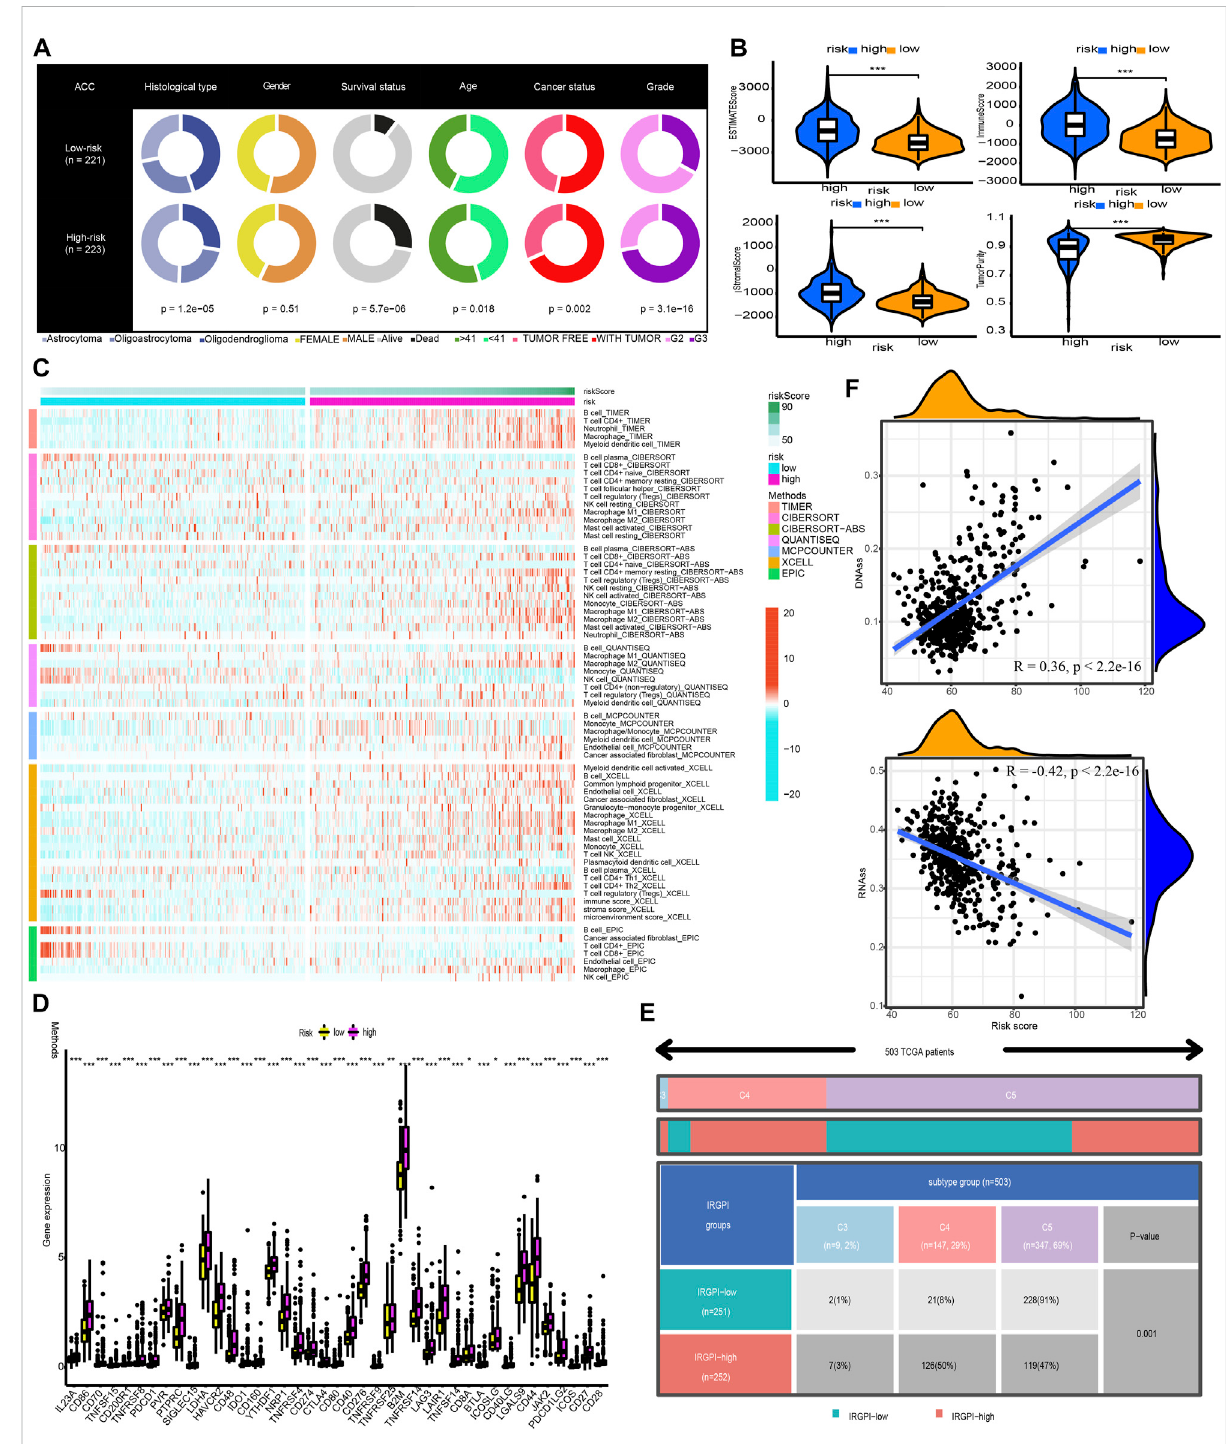
FIGURE 8 Clinical characteristics, immune characteristics, and tumour stem characteristics in the training cohort. (A) Pie charts illustrating the Chi- squared test of clinical and pathologic features between low- and high-risk categories (B) Analyses thesimilarities and differences between low-risk and high-risk groups in terms of TME components. (C) The immune cell in fi ltration landscape within the training cohort. (D) The expression pro fi les ofICGsinthetrainingcohort. (E) Heatmapandtableillustrating theimmunesubtypes(C3,C4,andC5)distributionbetween low-andhigh-risk categories. (F) The correlation analysis between tumour stemness index and risk